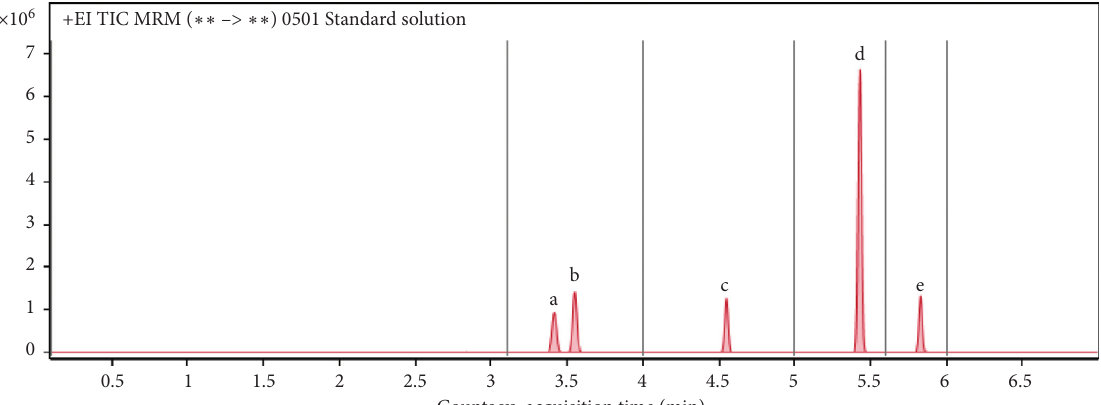
Figure 1: Total ion chromatogram of five volatile organic compounds of soy sauces. a: cyclohexane, b: benzene, c: toluene, d: chlorobenzene, e: styrene.